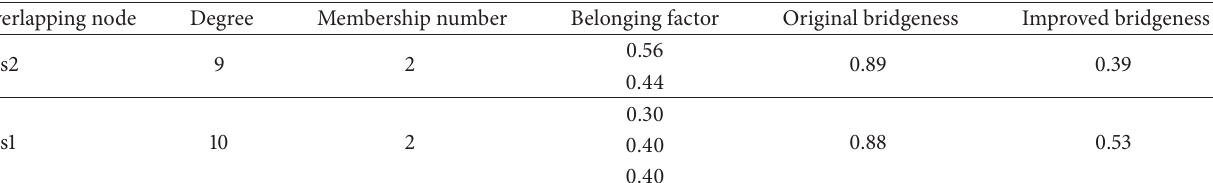
Table 3: The detailed information of overlapping nodes in Protein reaction network.